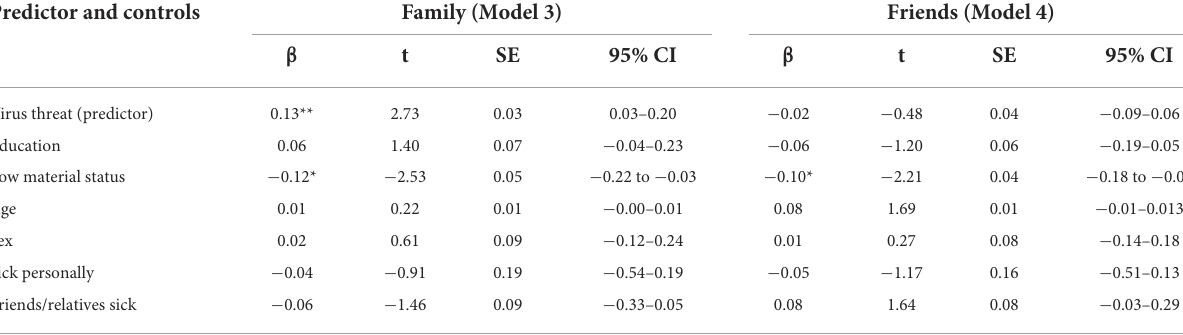
TABLE 3 Relation between perceived coronavirus threat and perceived closeness with family and friends (simple linear regression with control of demographic variables, N = 500). Predictor and controls